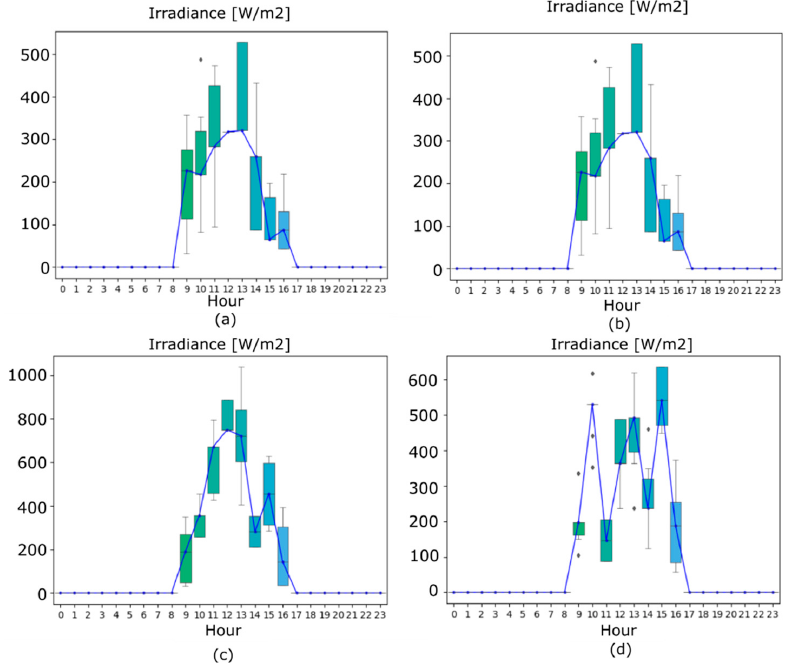
Figure 6. Median scenarios (blue) with box-whisker plot for scenarios generated for January using 𝑛 (cid:3020) = 1000 , 𝑛 (cid:3017) = 10 , 𝑛 (cid:3019) = 7 , and metric = ℓ (cid:2870) -Norm and varying p : 1.5 ( a ), 1 ( b ), 0.5 ( c ), and 0.15 ( d ).